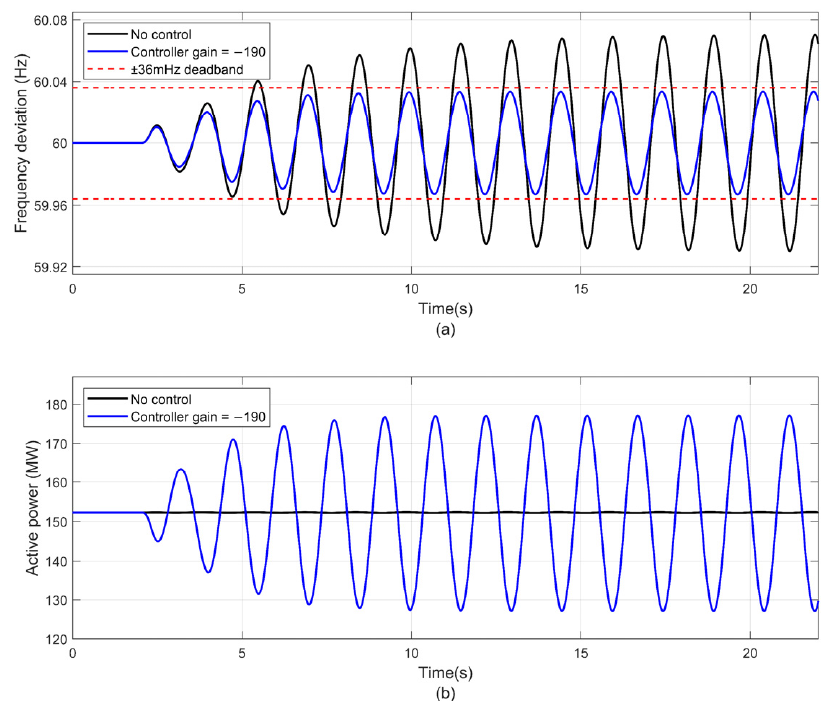
Figure 8. ( a ) Area 4 Zone 19 frequency deviation improvement. ( b ) Active power output of the actuator at Area 4 Zone 19 when the forced source is at Area 4 Zone 19.